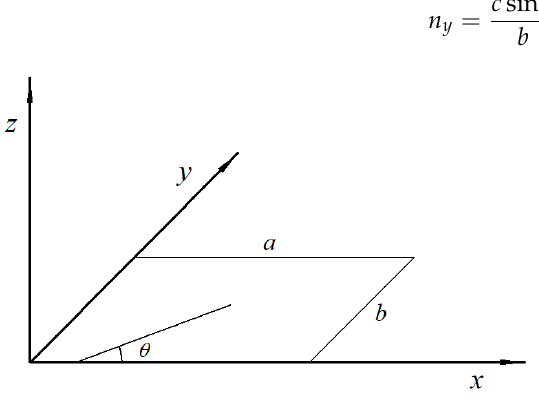
Figure 1. An energy ray in the membrane.